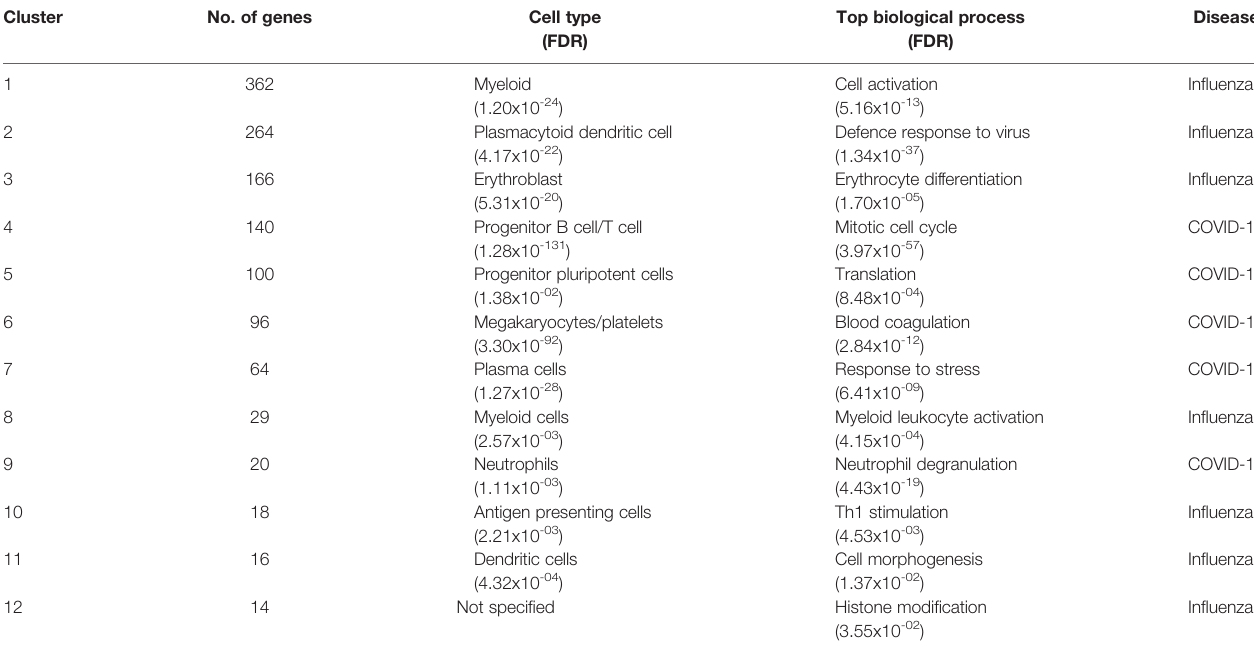
TABLE 3 | Summary of the top 12 BioLayout